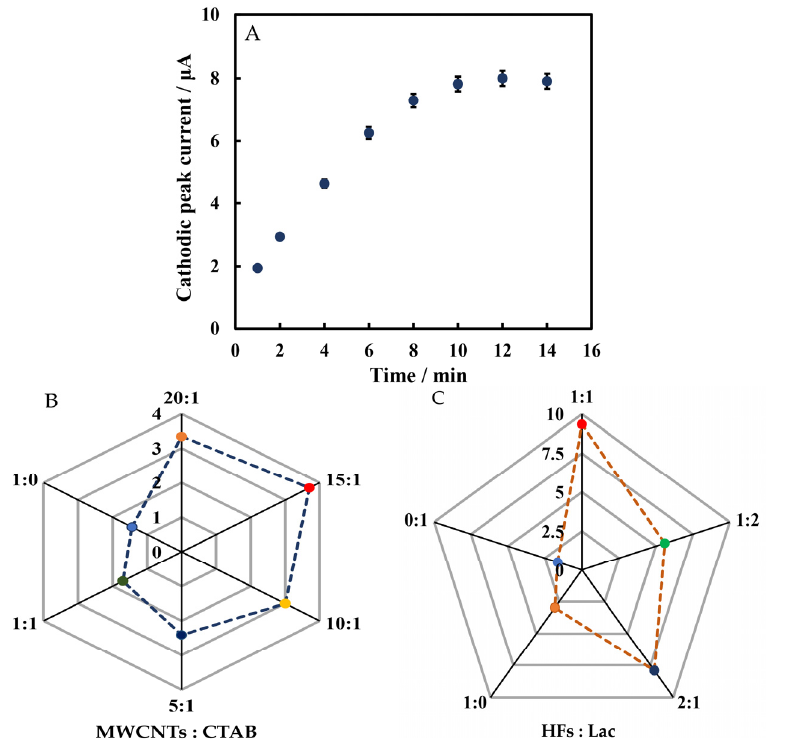
Figure 7. LSVs versus determination time ( A ), the optimal ratios of MWCNTs to CTAB ( B ) and HFs to Lac ( C ) for the the modified electrode in 50 mmol L − 1 pH 4 phosphate-buffered solution containing 5 µmol L − 1 rutin.